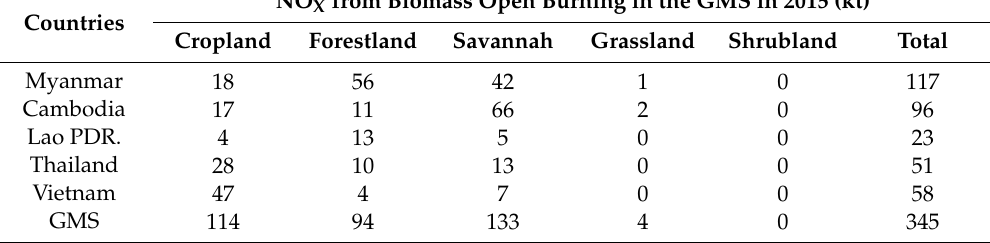
Table A5. The actual amount of NO X from biomass open burning classified by vegetation types in the GMS in 2015.